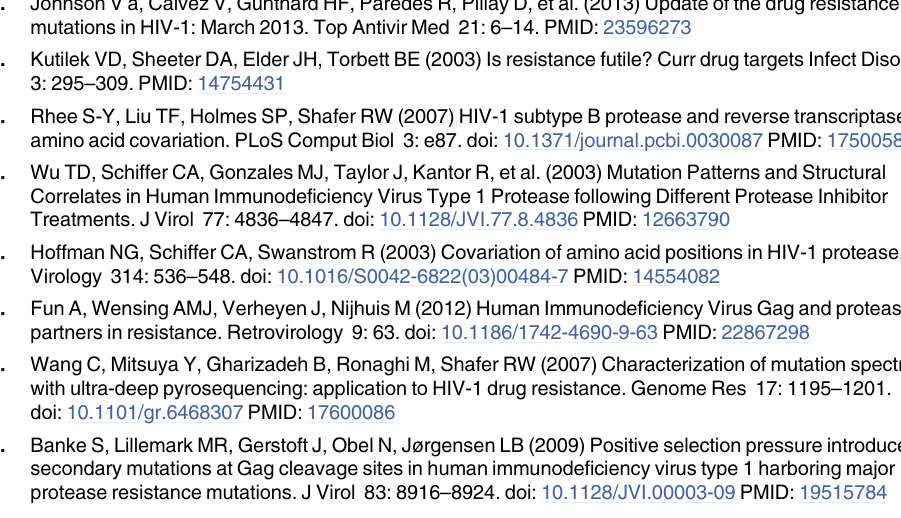
S7 Table. Distribution of atom-atom distances among models in PDBs derived from NMR. Some of the distance calculations used in Tables 5 and S6 are derived from ensembles of struc- tures. Shown here are the minimum, mean, and maximum atom-atom distances for all affected position pairs calculated from each PDB with an ensemble of structural models. For distances < 8Å, we find there to be little variability across structural models. S8 Table. PR-PR pairs ranked by Fisher exact test p-value calculated from 2013 HIVDB se- quences. We show a comparison between PR-PR pair rankings calculated using Fisher ’ s exact test on a MSA provided by the Stanford HIVDB [24] dated 4/29/2013 and the permutation test presented in